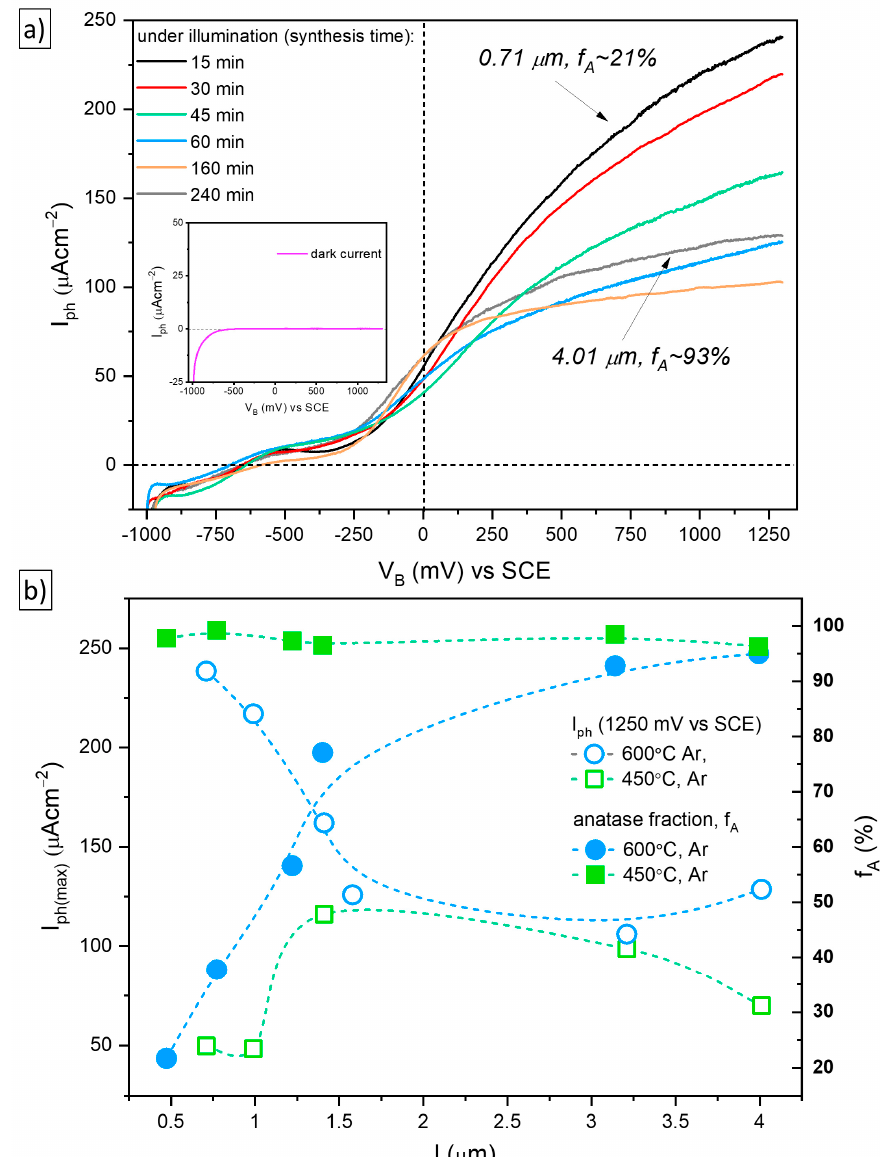
Figure 7. Characteristic of current vs voltage, Iph-VB for flower-like TiO 2 nanostructures after annealing at 600°C in argon ( a ) and dependence of the photocurrent (at 1250 mV) and anatase fraction on the electrode thickness ( b ).